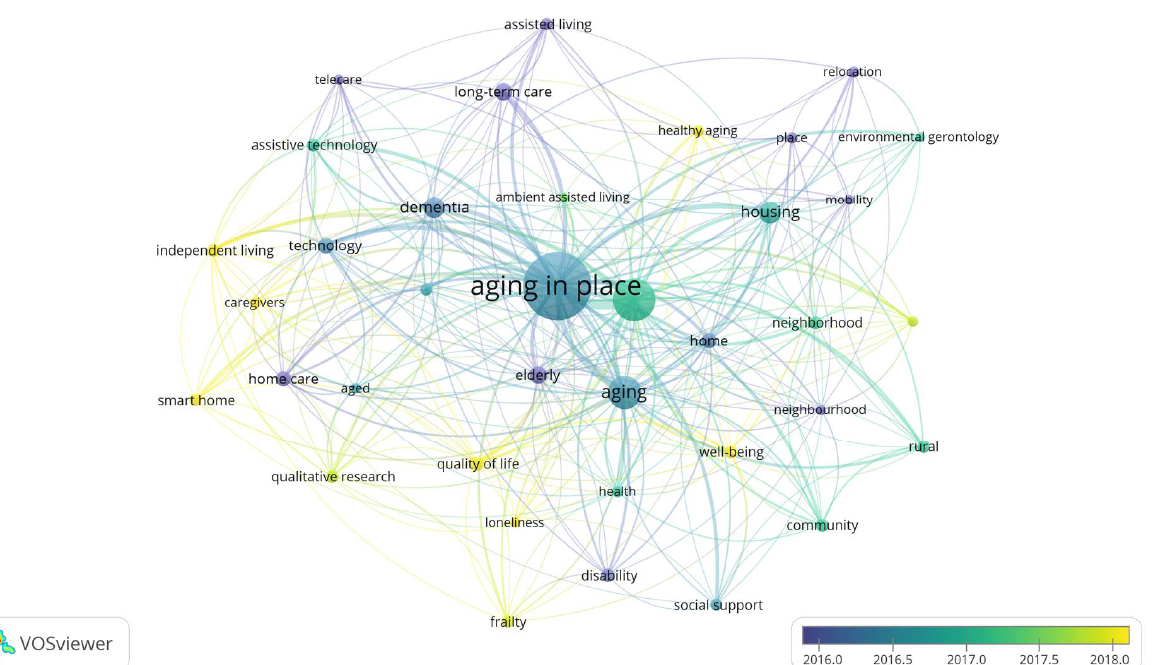
Figure 5: Overlay visualization of keywords